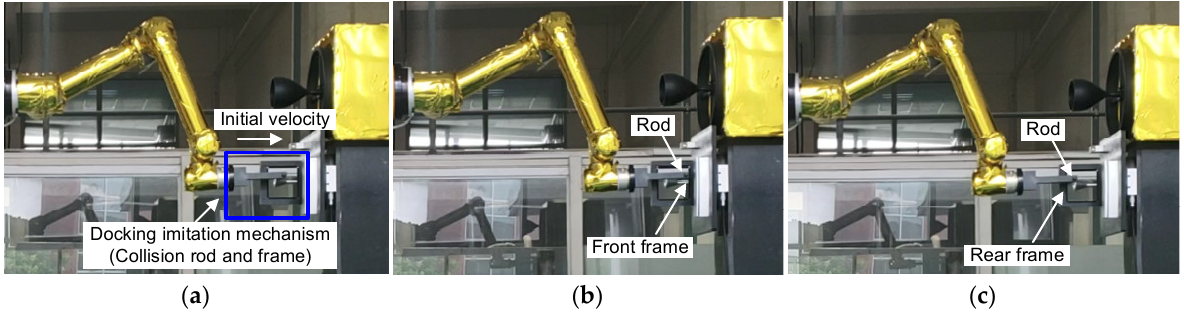
Figure 10. An example of contact process. ( a ) Initial position. ( b ) Contact with front frame. ( c ) Contact with rear frame.